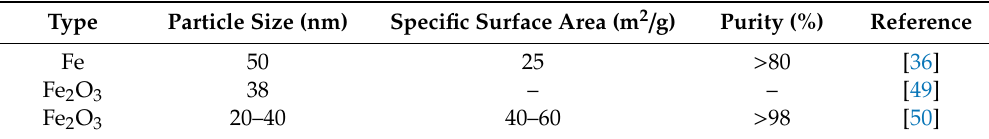
Table 3. Properties of nanoiron used by several